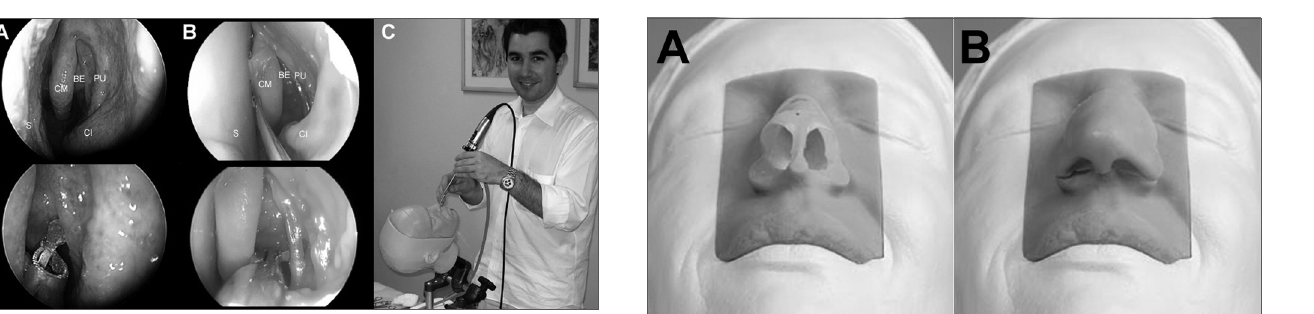
Figura 6. Modelo para treinamento de rinoplastias. A: modelo com cartilagens expostas. B: modelo com pele sintética recobrindo as cartilagens. A parte branca é um molde de cabeça fixo. A parte com coloração da pele é um módulo com pele e cartilagens sintéticas que são dissecáveis e pode ser